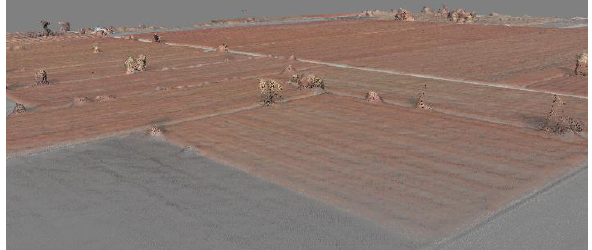
Figure 6. 3D point cloud of the test